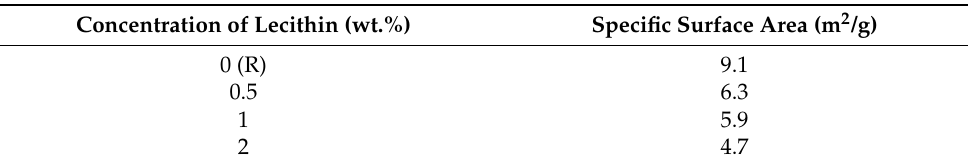
Table 6. Specific surface area for ionically crosslinked alginate xerogels with the addition of lecithin determined by gas sorption.